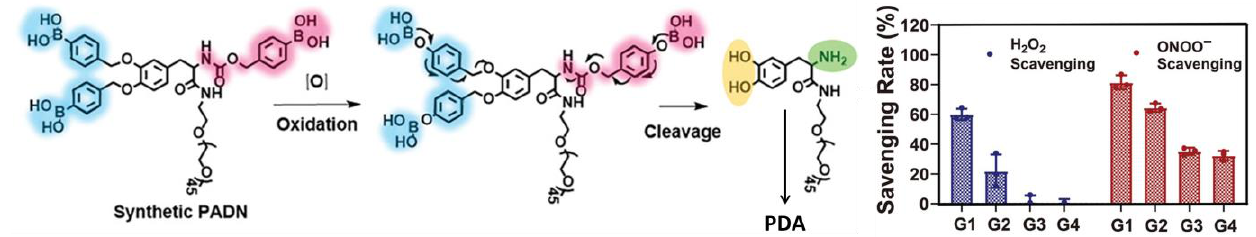
Figure 5. The designed PADN acts as a tyrosine mimic to scavenge reactive oxygen species (ROS) by oxidative polymerization similar to natural tyrosine. H 2 O 2 and ONOO − -scavenging effect of PADN, PEG-Dopa, ONOO − -oxidized PADN and Mel-NPs, respectively (G1: PADN; G2: PEG-Dopa; G3: ONOO − -oxidized PADN; G4: Mel-NPs). Reprinted with permission from ref. [106].